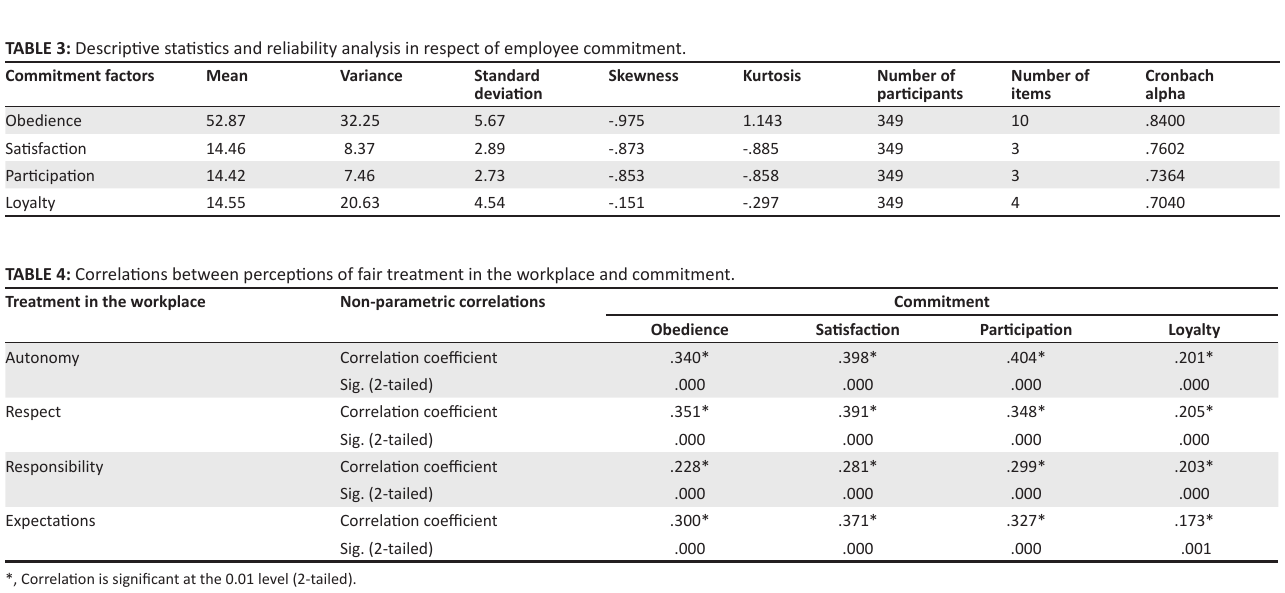
Responsibility Expectations